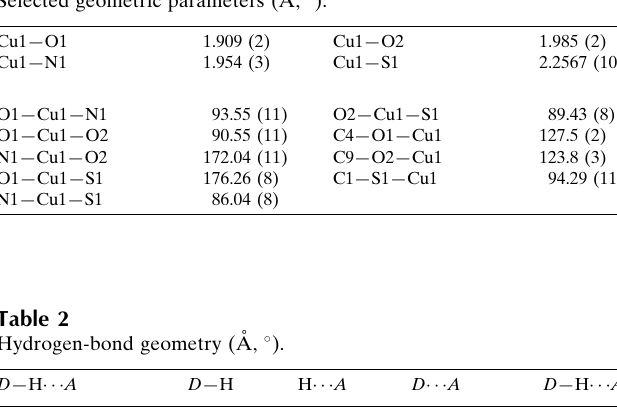
Selected geometric parameters (A˚ , (cid:2) ).